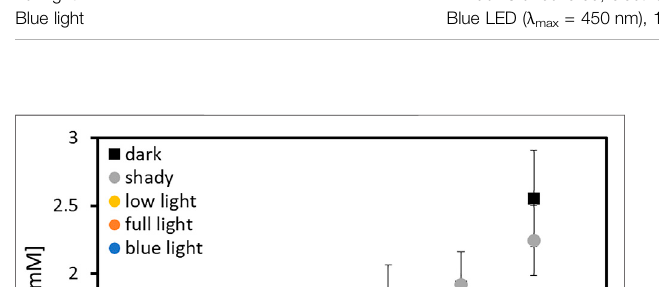
Frontiers in Catalysis |